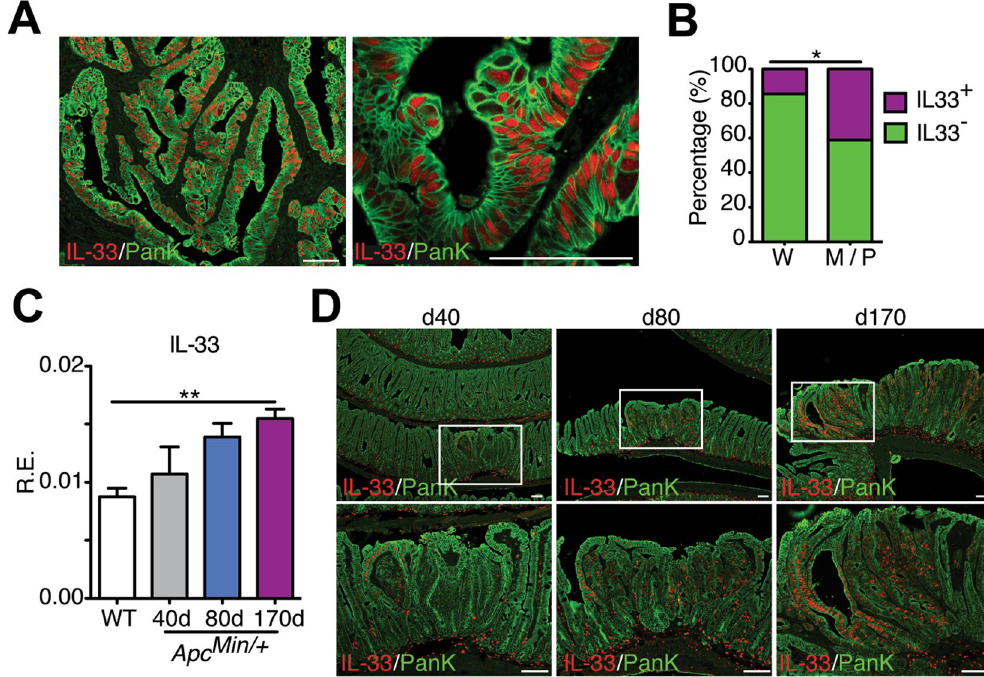
Figure 1. IL-33 expression in human colorectal cancer patients and in Apc Min/ + mice model. ( A ) Paraffin sections from a tissue microarray of human colorectal cancer (CRC) patients were stained with IL-33 (red) and Pan keratin (green). Representative photographs show expression of IL-33 by intestinal epithelial cells (IECs) in poorly differentiated adenocarcinomas. Scale bars, 100 μ m. ( B ) The percentage of IL-33 immunolabeling in the IECs from 21 well-differentiated CRC patients (W) and 68 moderate- and poor-differentiated CRC patients (M/P). * P < 0.05, Fisher exact test. ( C ) Relative expression levels of IL-33 mRNA were analyzed by qPCR in the gut of Apc Min/ + mice at various ages. Data were normalized to the expression levels of the Ubiquitin transcript. Means ± s.e.m., n = 4 per group. ** P < 0.01, nonparametric Mann-Whitney test. ( D ) Immunofluorescence staining for IL-33 (red) and Pan keratin (green) in Apc Min/ + mice at different ages. Zoomed-in boxed area shows IL-33 immunolabeling in the IECs in Apc Min/ + mice. Scale bars, 50 μ